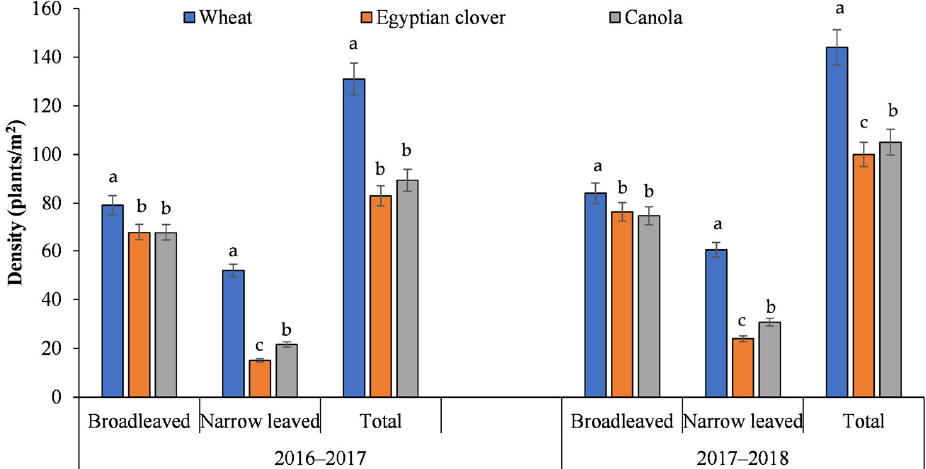
Figure 2. The impacts of different winter crops on weed density ( ± standard errors of means, n = 3) in different winter crops included in the study.